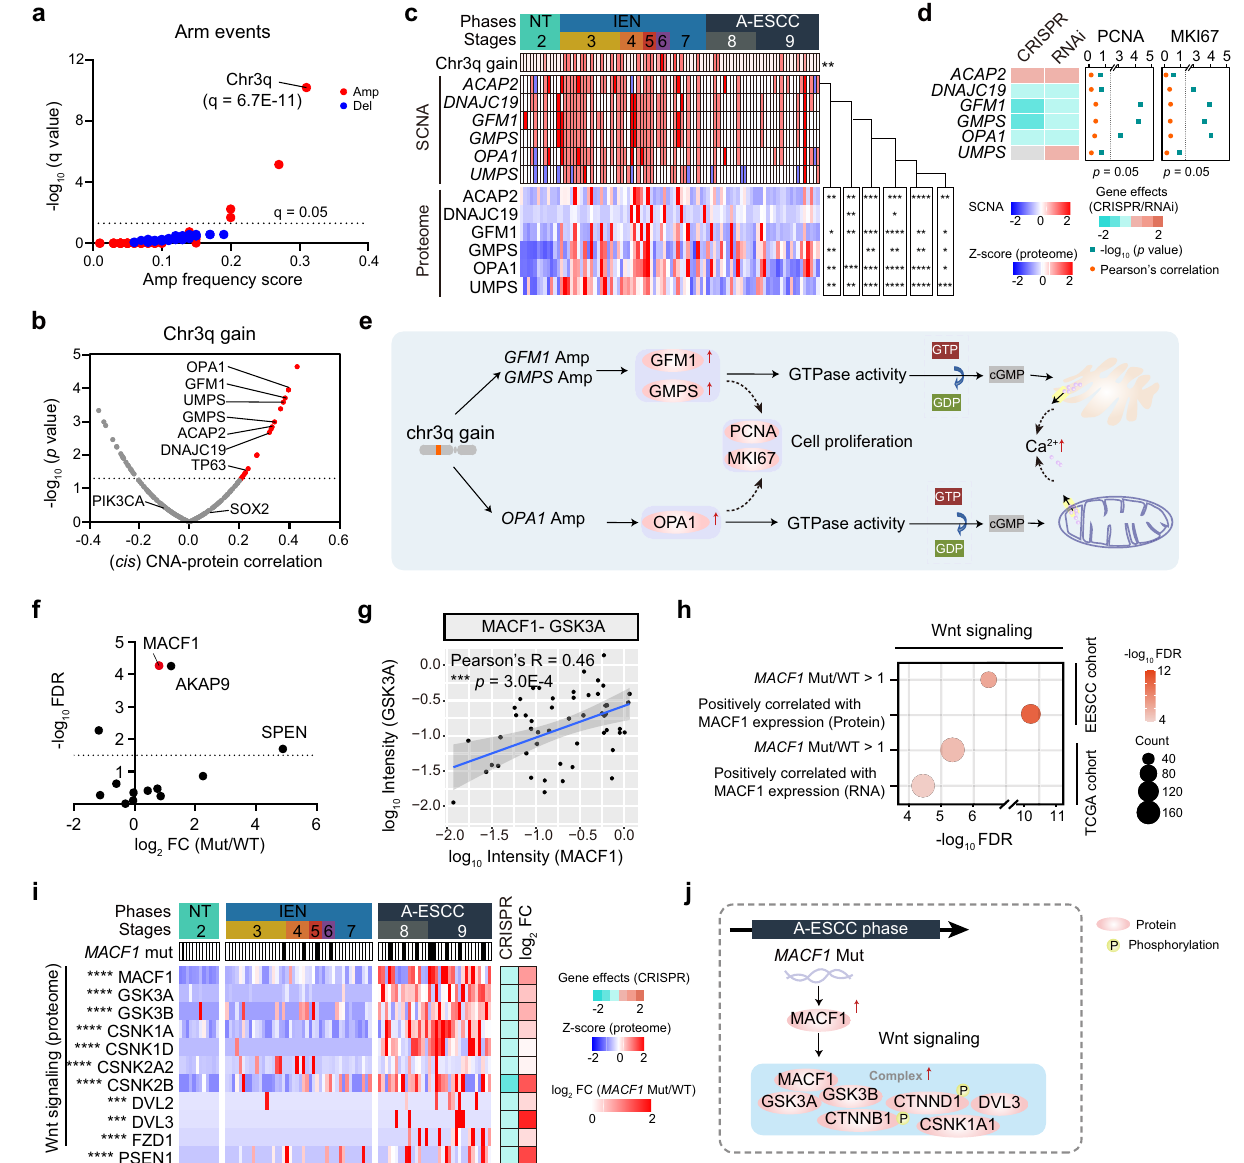
Fig. 3 | Integrative omics analyses of early ESCC samples. a The signi fi cant arm eventsof102samplesinESCCprogression.Thegainandlosseventsarehighlighted in red and blue, respectively. b Volcano plot showing the cis - correlation of the SCNA( x -axis)andtheassociated – log 10 ( p value)( y -axis)onthegenesatchr3qgain (two-sided Spearman ’ s correlation test). c The cis SCNA-protein regulations of signi fi cantly correlated genes (top) on their corresponding proteins expression (bottom) (two-sided Spearman ’ s correlation test, p <0.05). d Dependency map- supported (https://depmap.org) panels showing relative survival averaged across all available ESCC cell lines after depletion of the indicated genes by RNAi or CRISPR. The right shows Pearson ’ s correlation and p value of these genes with PCNAandMKI67attheproteinlevel(two-sidedPearson ’ scorrelationtest). e Abrief summary of the impacts of chr3q gain. f Volcano plot showing the impacts of the top ten mutations of ESCC progression on proteins expression (log 2 -transformed